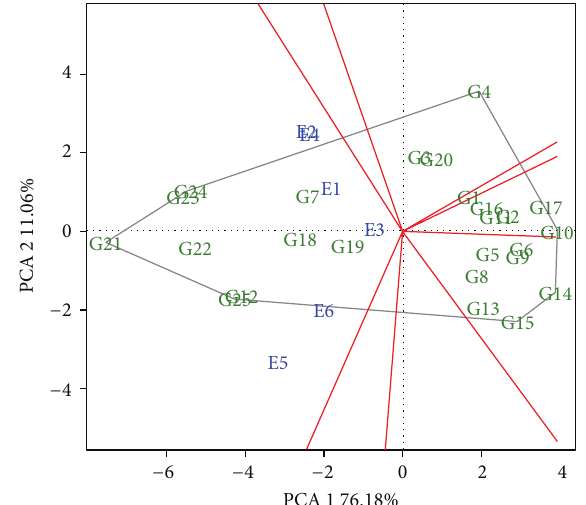
Figure 3: GGE biplot graph, evaluating grain yield (t ha −1 ), with the groupingofthesixlocations(Vacaria,RS;AbelardoLuz,SC;Candoi, PR; Canoinhas, SC; Castro, PR; and Ponta Grossa, PR), identified from E1 to E6, respectively, the gray line represents the polygon formed by genotypes evaluated.